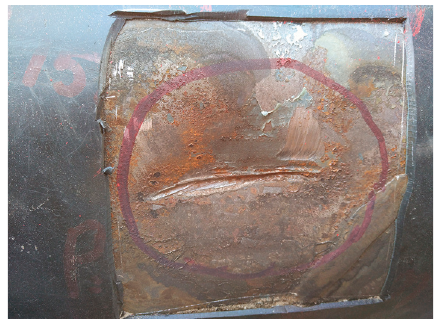
Figure 3: Actual damage diagram of the